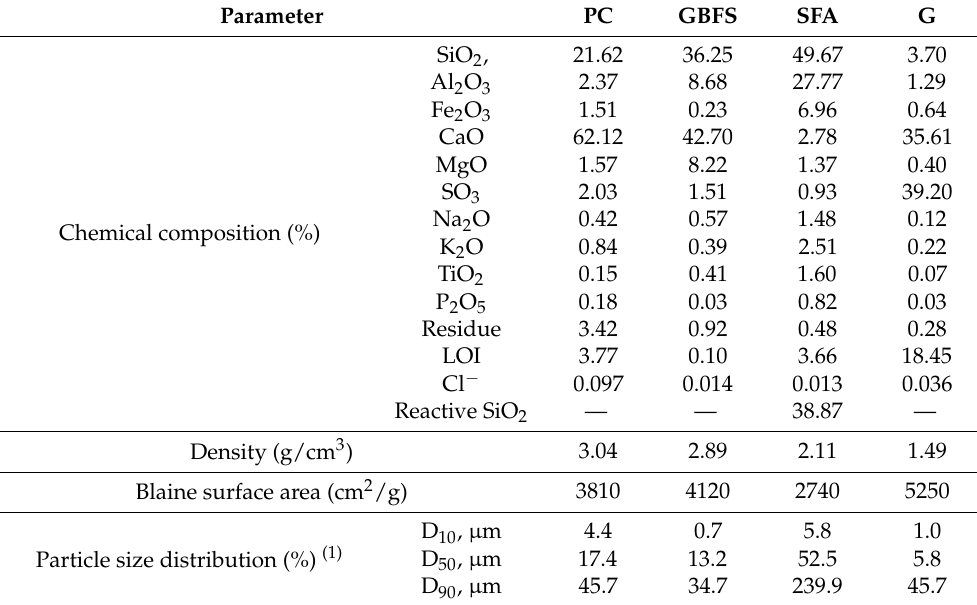
Table 1. Chemical composition and physical characteristics of the materials. Parameter PC GBFS SFA G SiO 2 , Al 2 O 3 Fe